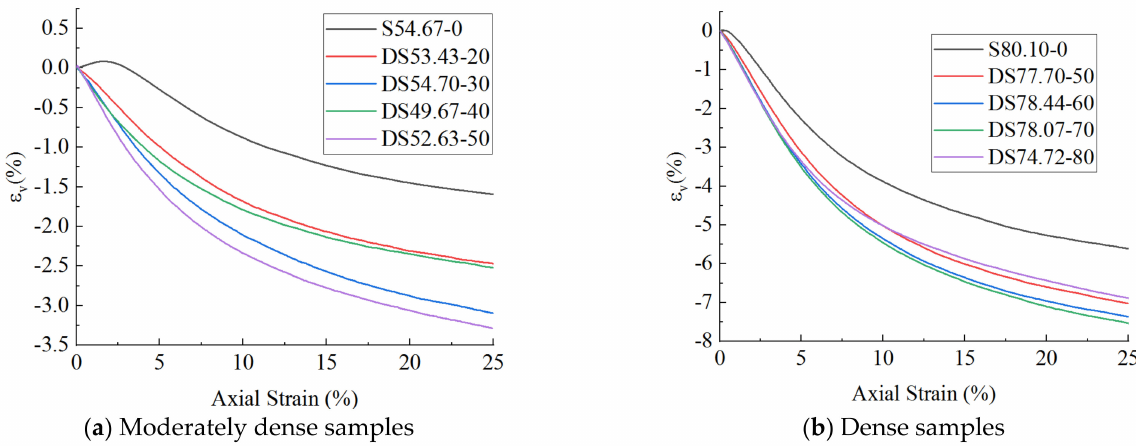
Figure 8. Volume-axial strain